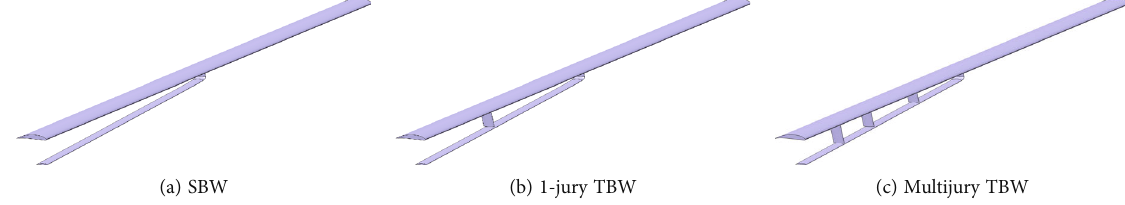
Figure 2: Di ff erent TBW con fi guration.